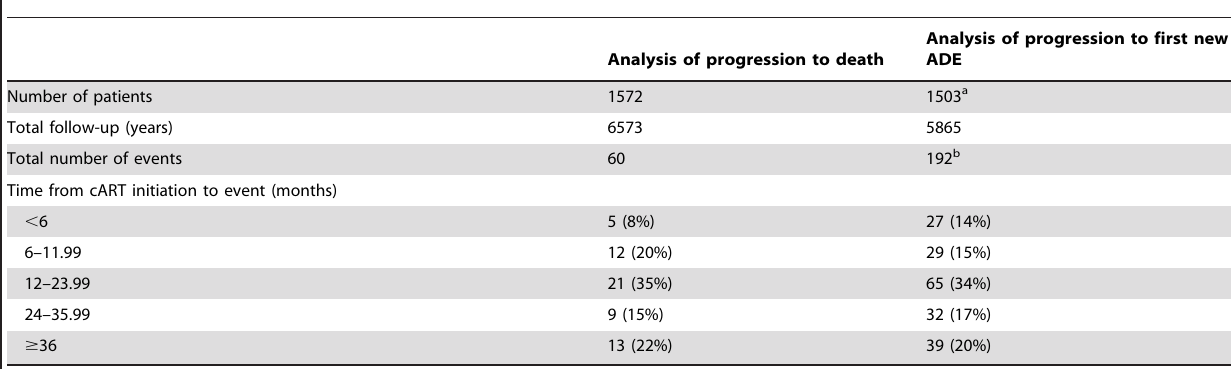
Table 2. Number of patients, events and years of follow-up contributing to